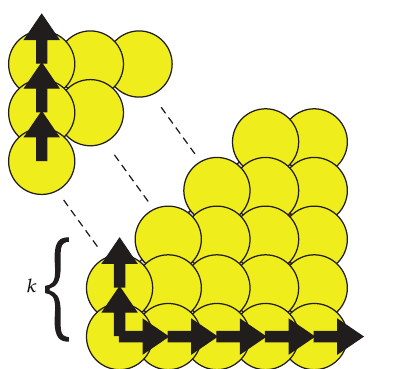
Figure 16: Factorization of C 3 crystal which leads to open BPS generating functions. The size k encodes the open BPS